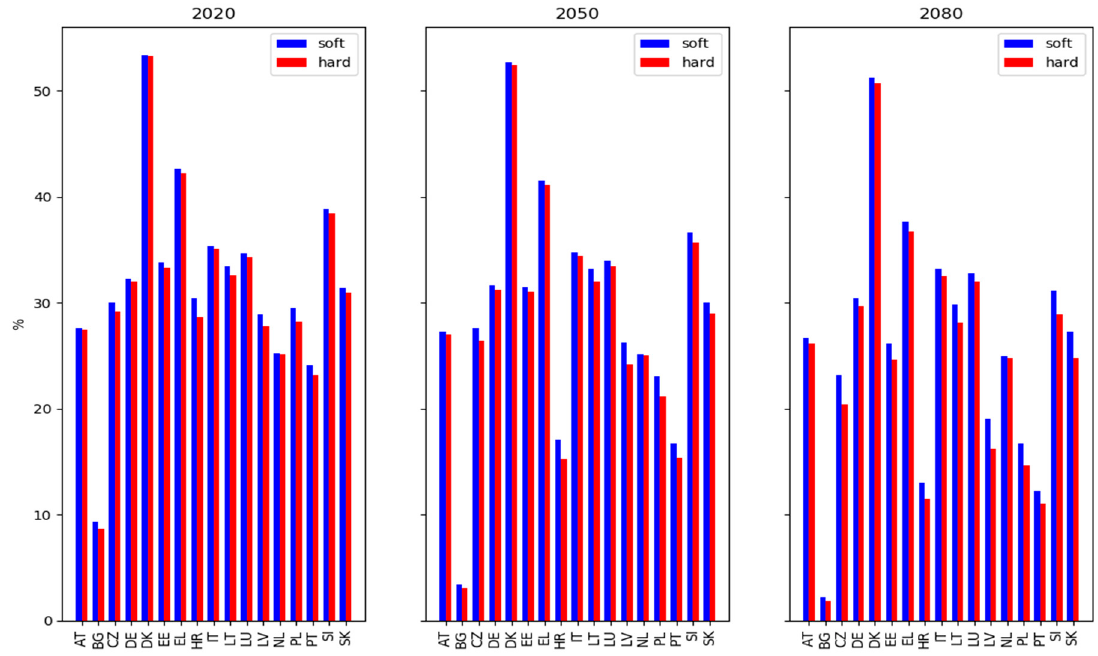
Figure A2. Projected uptake of voluntary insurance under soft market conditions (blue) and hard conditions (red), for EU countries in 2020, 2050, and 2080, for RCP8.5. Countries that provide public reinsurance for flood insurance are excluded here, as these are not exposed to global reinsurance market volatility resulting from large natural catastrophes. Additionally, countries with semi-voluntary insurance systems are excluded here, since insurance uptake is a mortgage requirement and is therefore less responsive to capital market shocks.